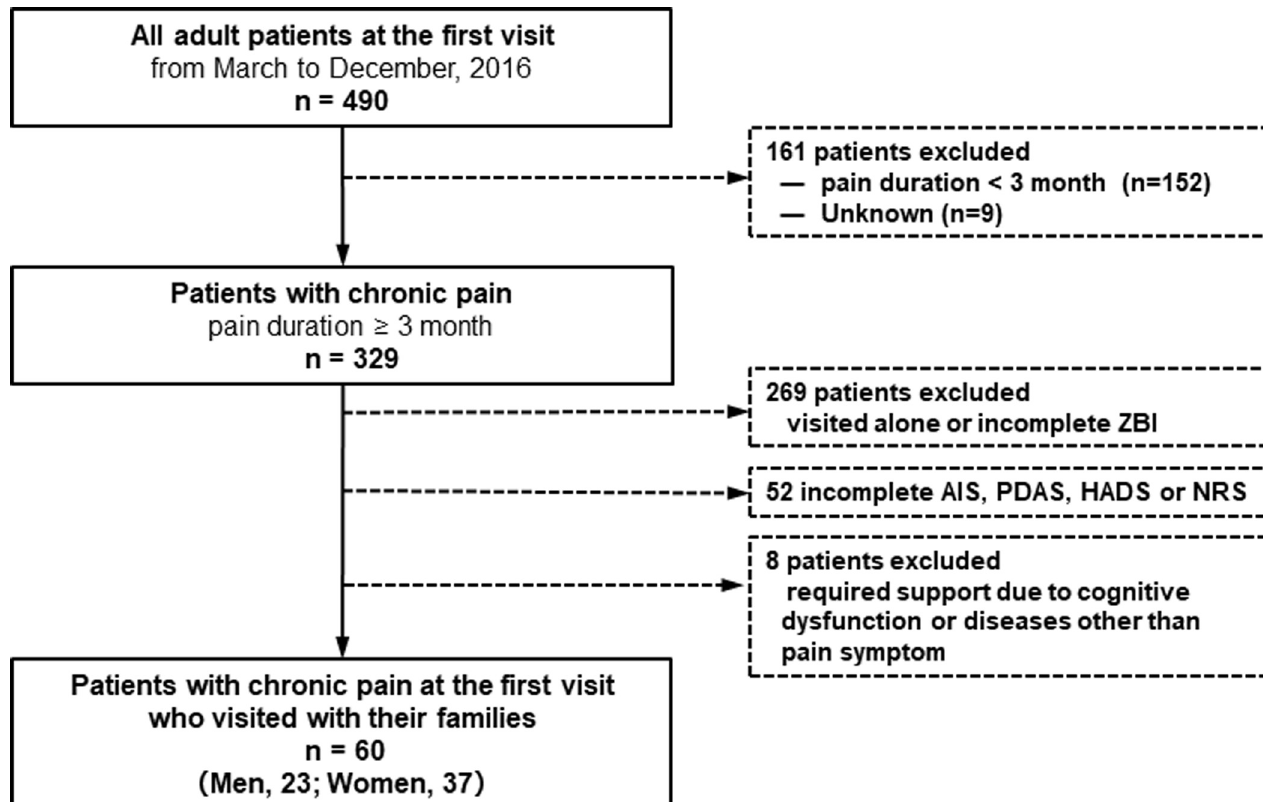
Fig 1. Diagram of the participant selection